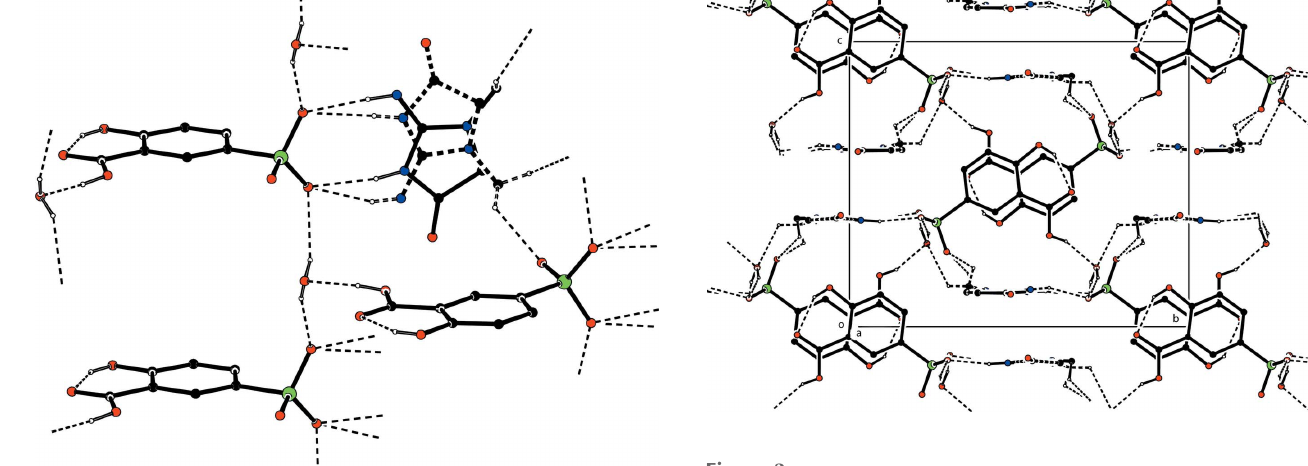
Figure 3 The crystal packing of the title molecular salt viewed along the a axis. The hydrogen bonds are shown as dashed lines. H atoms not involving in hydrogen bonds have been omitted for clarity.